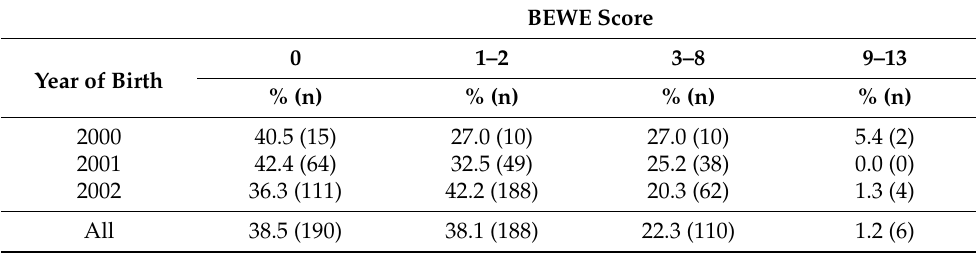
Table 4. Distribution of BEWE score values.